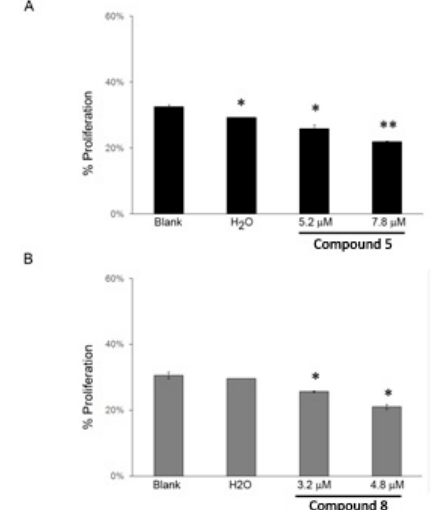
Figure 3. NCI-H460 cellular proliferation following 48 h treatment with compounds 5 ( A ) and 8 ( B ), analyzed with the BrdU incorporation assay. Cells were treated with the GI 50 (5.2 µ M) and 1.5 × GI 50 (7.8 µ M) of compound 5 and with the GI 50 (3.2 µ M) and 1.5 × GI 50 (4.8 µ M) of compound 8 . Cells were also treated with the corresponding highest concentration of vehicle (solvent) of the compounds (H 2 O). Results represent the mean ± SEM of three independent experiments. * p ≤ 0.001, ** p ≤ 0.05 between Blank vs. treatment.